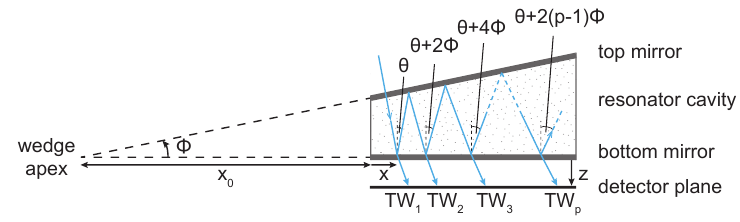
Figure 2. Propagation of a light beam in an